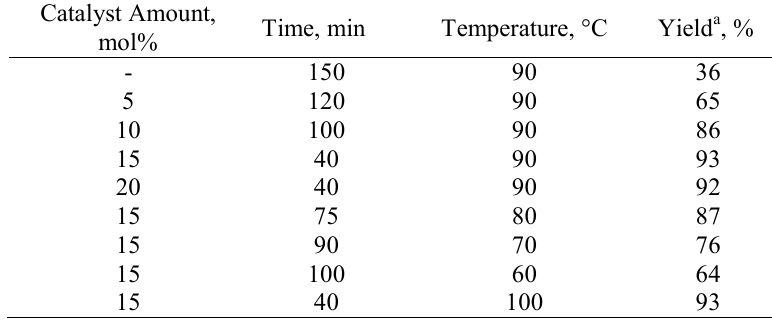
Table 1. The reaction of dimedone with 4-methoxybenzaldehyde using different molar ratios of SaSA at range of 60-100 °C.